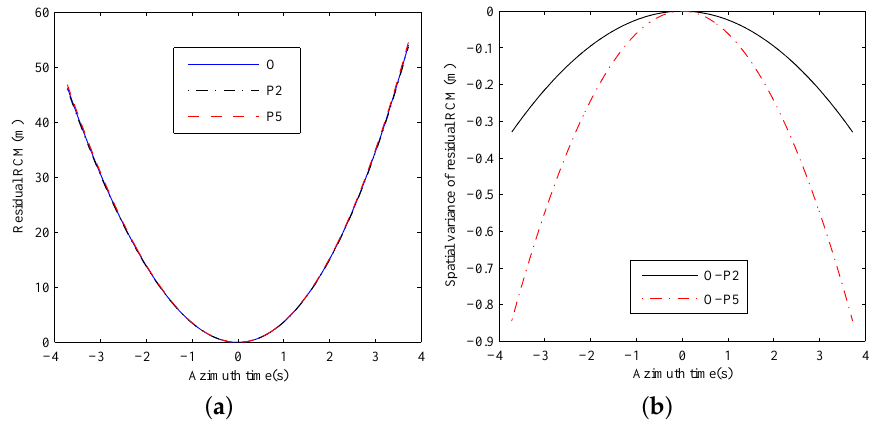
Figure 6. Residual range cell migration (RCM) after KT, and its spatial variance. ( a ) Diagram of residual RCMs of O, P 2, and P 5 after KT; ( b ) Spatial variance of residual RCM between O and P 2, O, and P